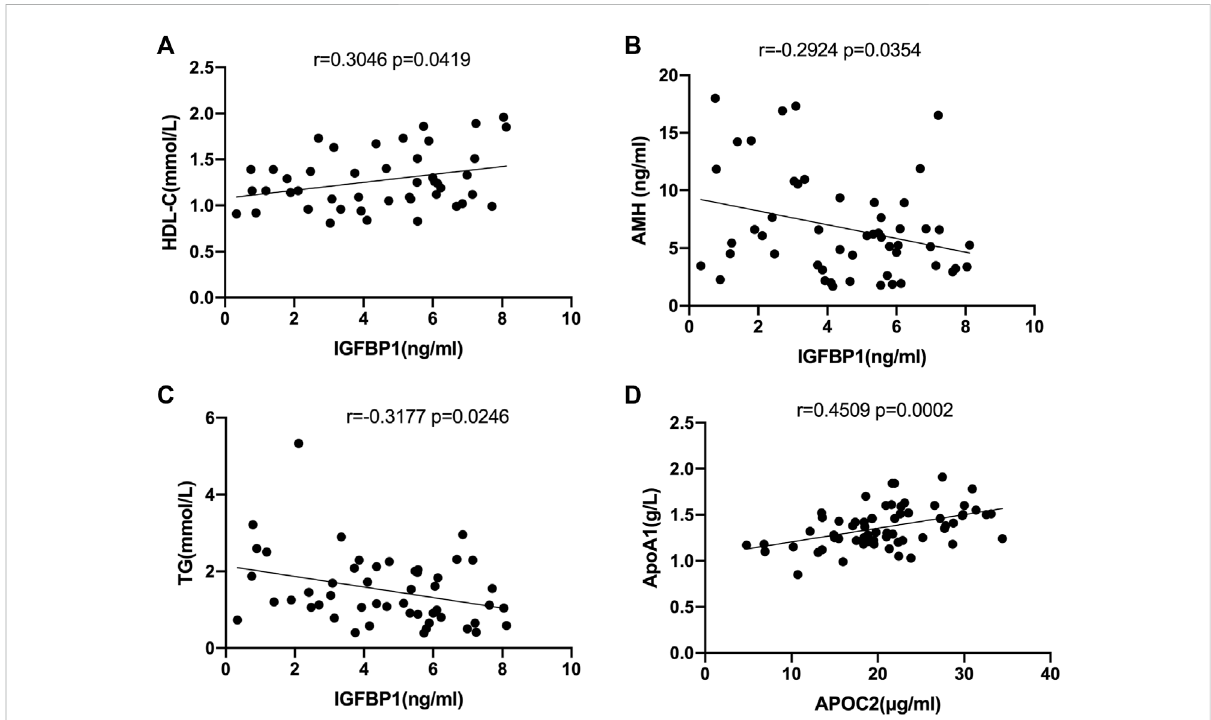
FIGURE 6 Correlation analysis ofselectedDEPs with clinical characteristics inall follicular fl uidsamples. (A) Correlation analysis ofIGFPB1 with LDL-C (r = 0.3046, p = 0.0419). (B) Correlation analysis of IGFPB1 with AMH (r = 0.2924, p = 0.0354). (C) Correlation analysis of IGFPB1 with TG (r = -0.3177, p = 0.0246). (D) Correlation analysis of APOC2 with APOA1 (r = 0.4509, p =